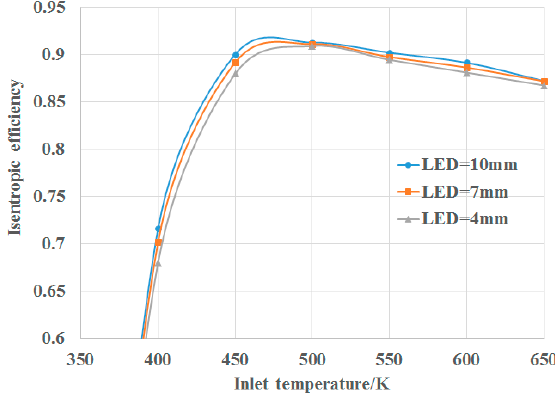
Figure 13. Correlation of inlet temperature towards isentropic efficiency.